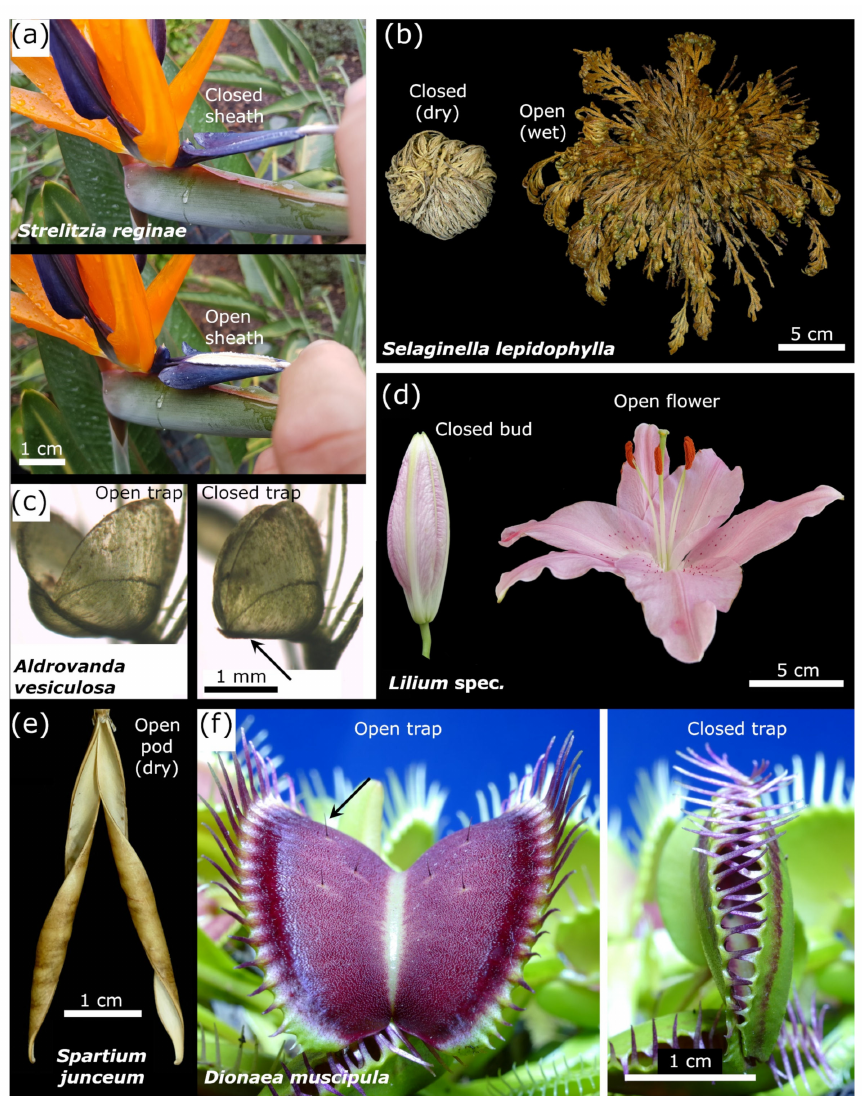
Figure 1. Biological concept generators for the compliant systems presented in this study. ( a ) The flower of the bird of paradise ( S. reginae ) features a motile sheath that opens upon application of a mechanical load. ( b ) The false rose of Jericho ( S. lepidophylla ) is in a strongly folded configuration when dry and unfolds during wetting. ( c ) The snap-trap of the carnivorous aquatic waterwheel plant ( A. vesiculosa ) closes after mechanical triggering of sensitive hairs inside the trap (not visible). The two trap lobes are connected by a midrib (arrow) and close because of the slight bending of the midrib but without curvature changes of the two trap lobes. Image modified after [37]. ( d ) The lily ( L. spec.) flower opens via edge-growth-based actuation of the individual petals. ( e ) The open seed pod of the Spanish broom ( S. junceum ) is an example of the hygroscopic seed pod of members of the Fabaceae. ( f ) The snap-trap of the carnivorous Venus flytrap ( D. muscipula ) closes after the mechanical triggering of sensitive hairs (black arrow), leading to a swift concave-convex curvature change of the two trap